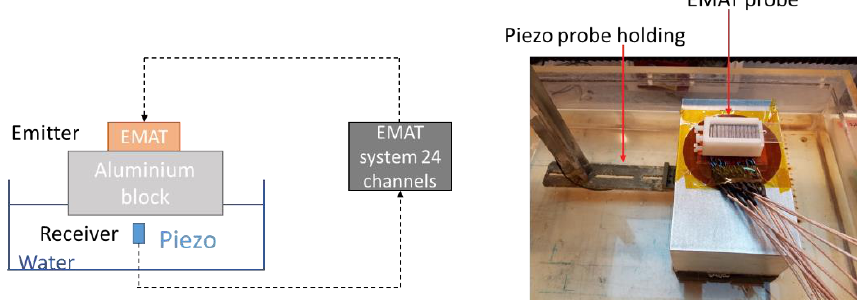
Figure 11. Experimental setup for transmission measurement — emission by the EMAT and reception by the piezoelectric probe.